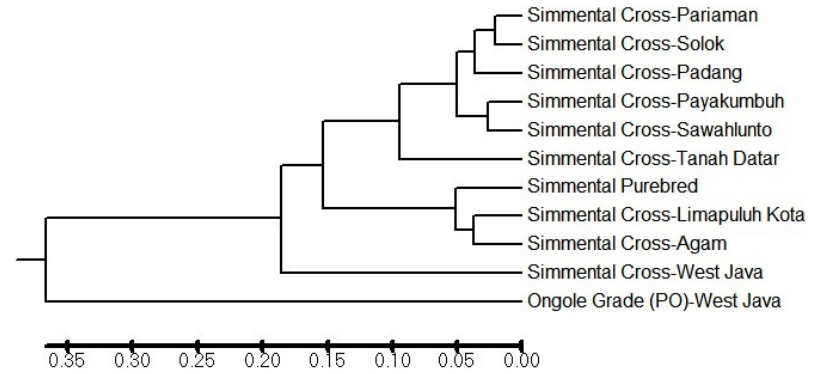
Figure 2. Dendrogram of Simmental Cross-West Sumatra subpopulation using Unweighted Pair-Group Method with Arithmetic mean method based on Nei et al.